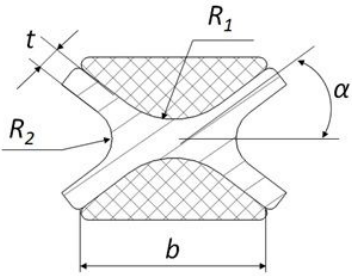
Figure 3: The characteristic dimensions of the gasket